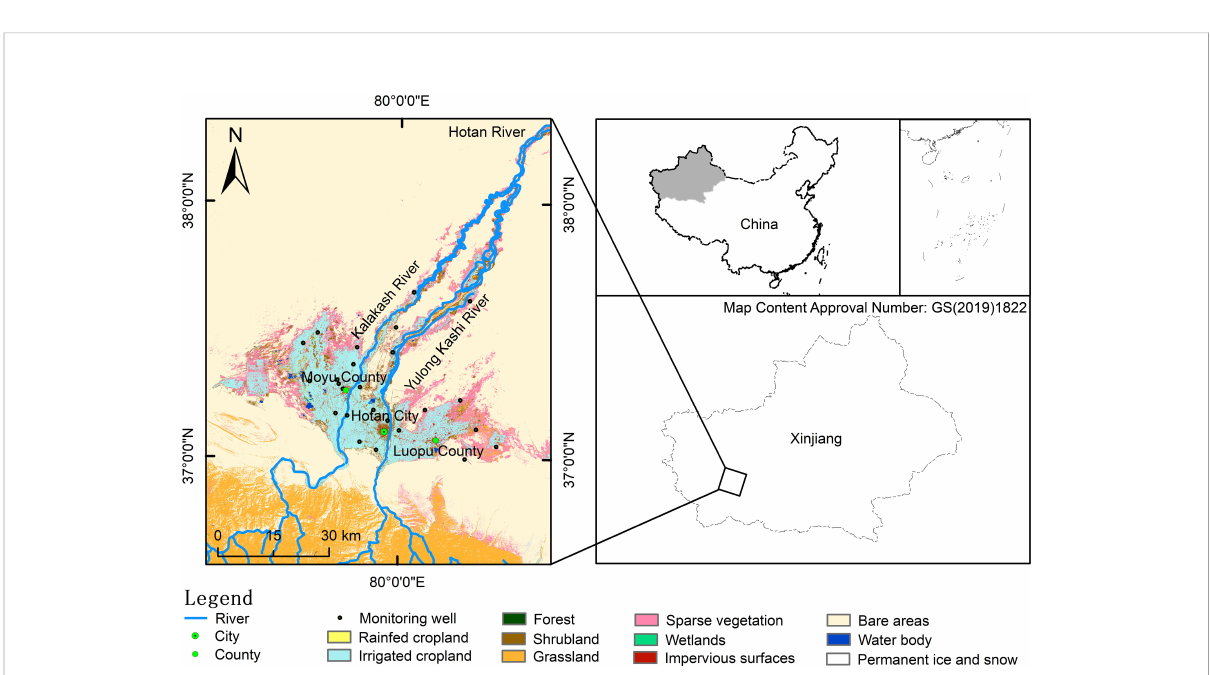
FIGURE 1 Location of the study area and Land-use type. Land-use type is based on the data from the Aerospace Information Research Institute, Chinese Academy of Sciences in 2020 (Zhang et al., 2021).